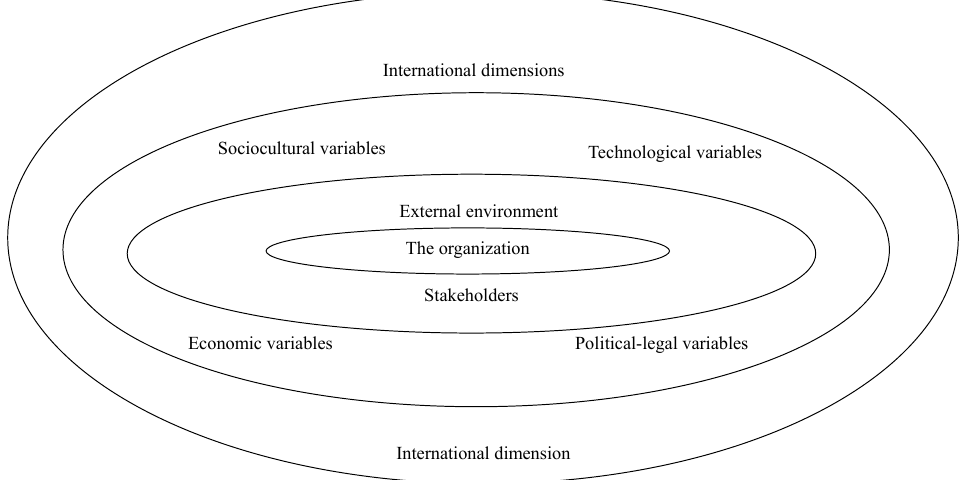
Fig. 2. Direct/indirect action environment model (Stoner & Freeman,